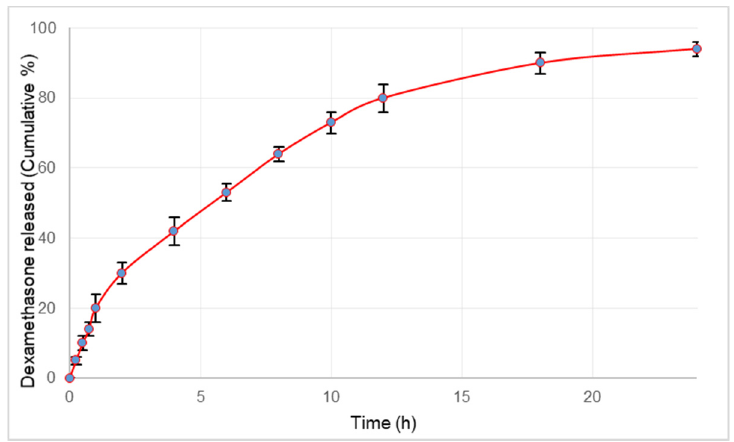
Figure 2. Release profile of dexamethasone from microspheres over a period of 24 h. Values plotted are the mean of 6 determinations and error bars indicate standard deviation.